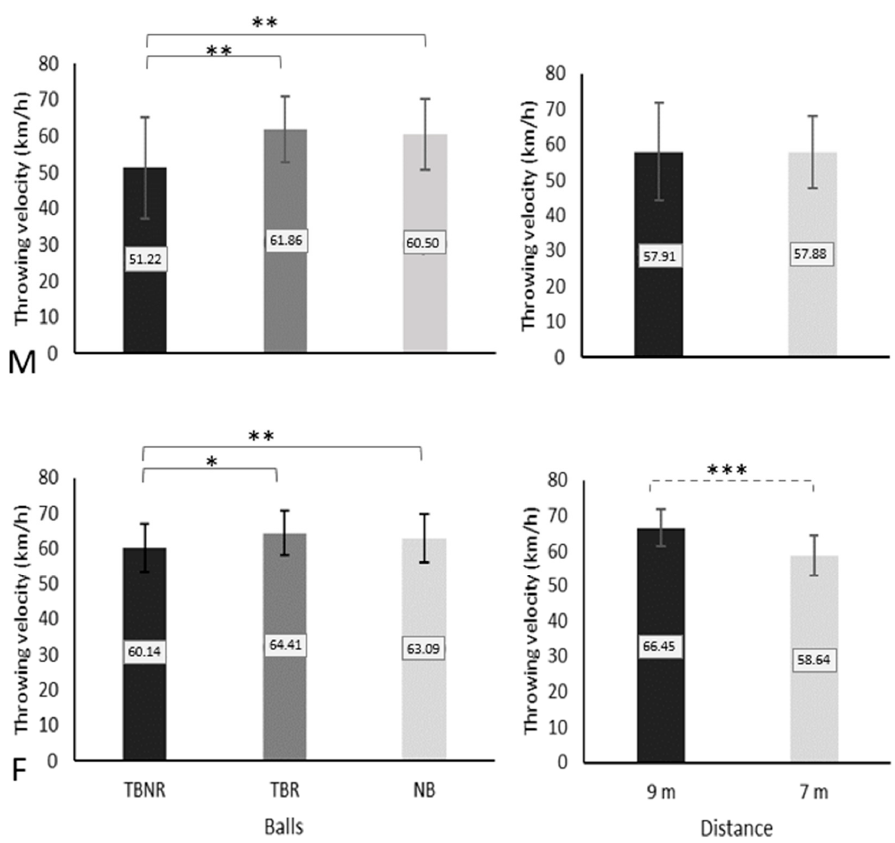
Figure 3. Male (M) and female (F) players’ throwing velocity (radar) for accuracy target according to throwing distance (7 and 9 m) and ball type (traditional ball with no resin—TBNR; traditional ball with resin—TBR; and new ball—NB). Note: continuous lines indicate significant differences between the three balls. Discontinuous lines indicate significant differences between the two throwing distances. * p < 0.05; ** p < 0.01, *** p < 0.001.